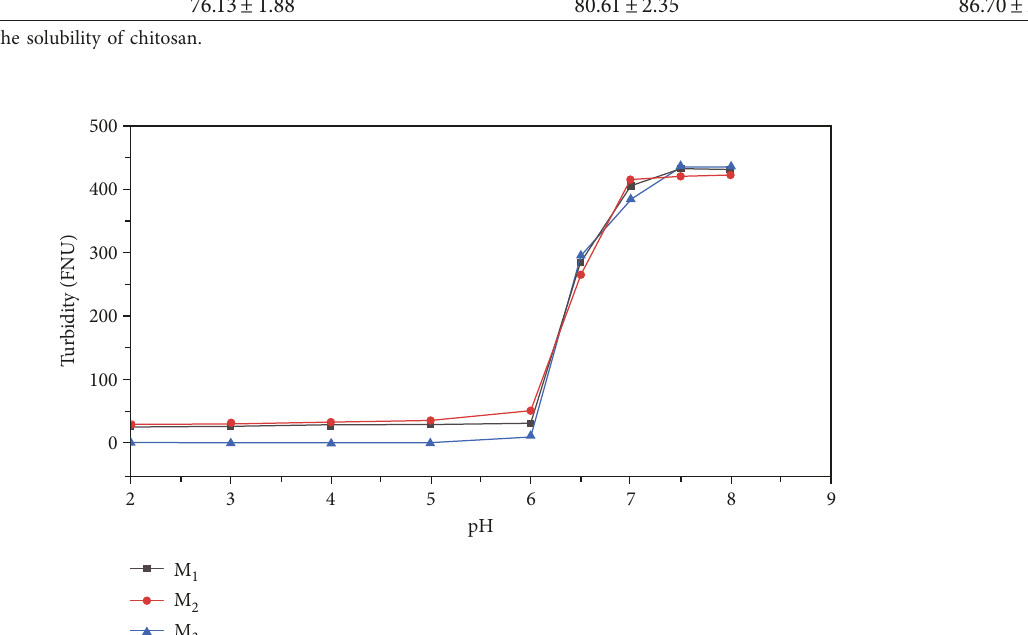
Figure 1: The turbidity of chitosan solution at different pH. Effect of the DD on the crystallinity and structure of chitosan.